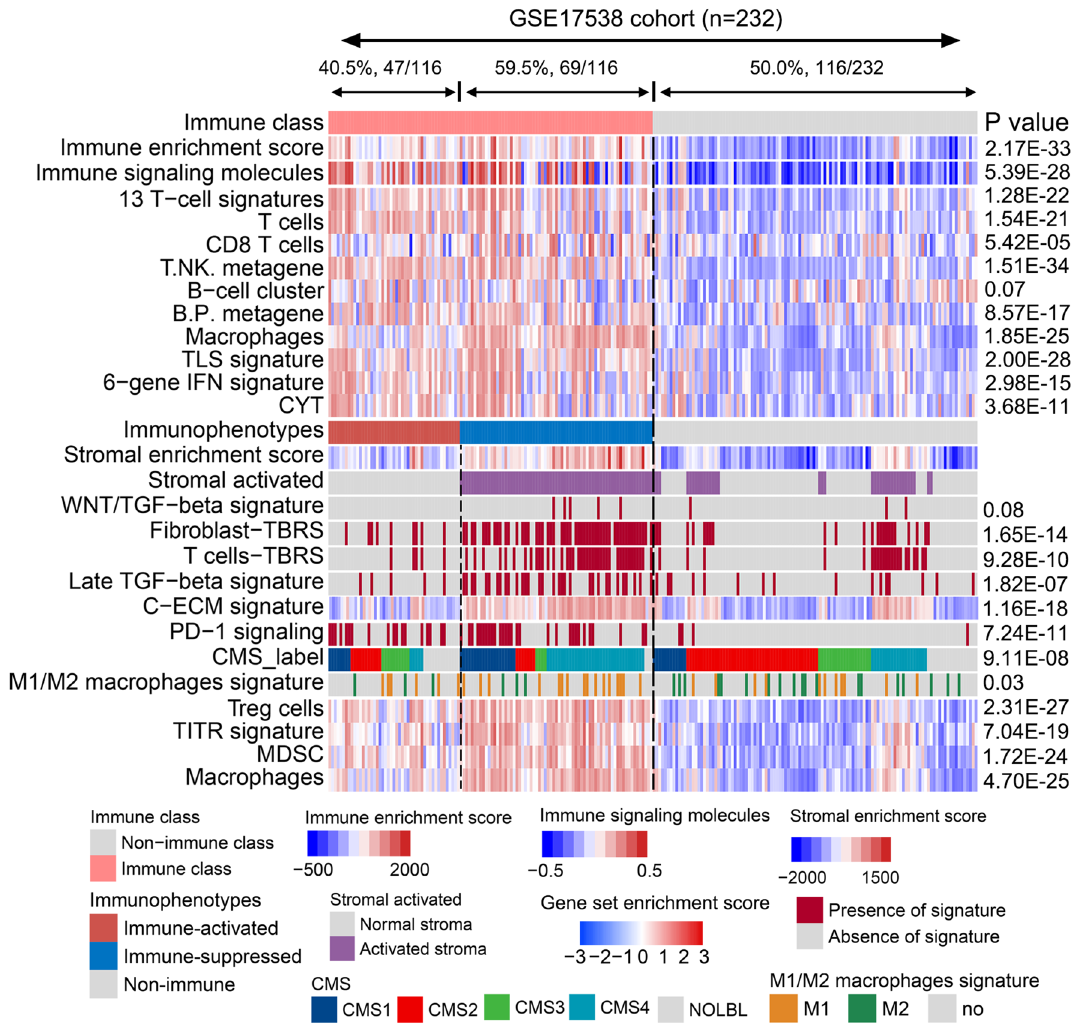
Figure 4. Validation of the immunophenotypes in the GSE17538